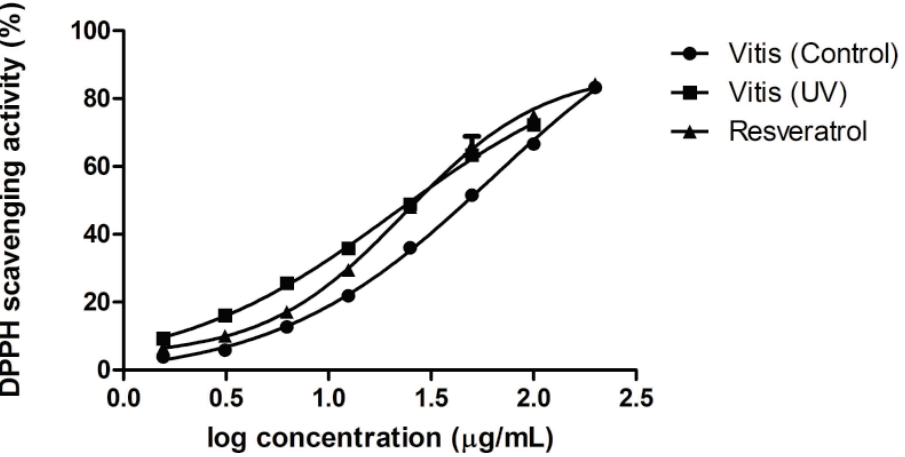
Figure 5. Dose-response curves of the radical scavenging activity on DPPH for V. vinifera control, V. vinifera UV and